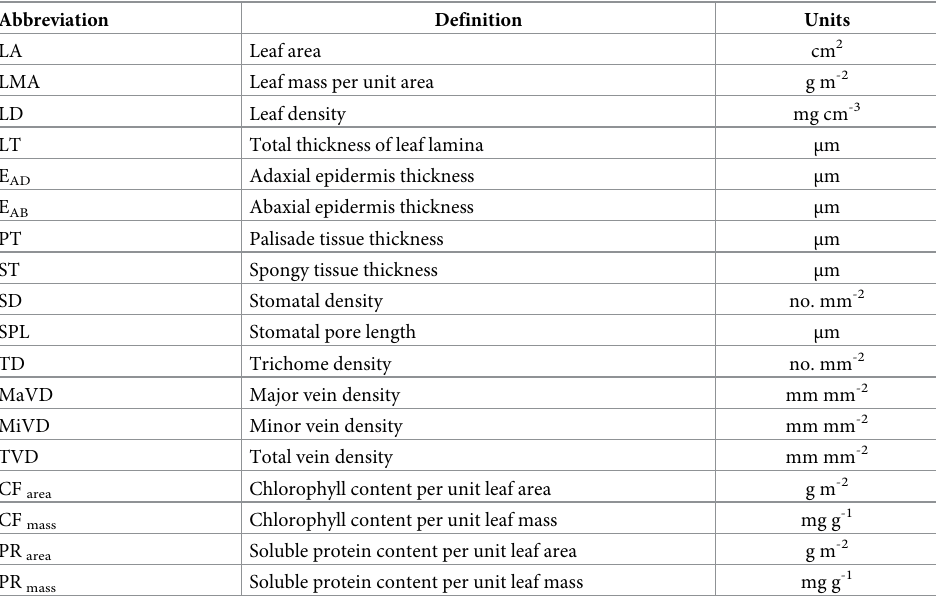
Table 1. Summarizing table of the measured